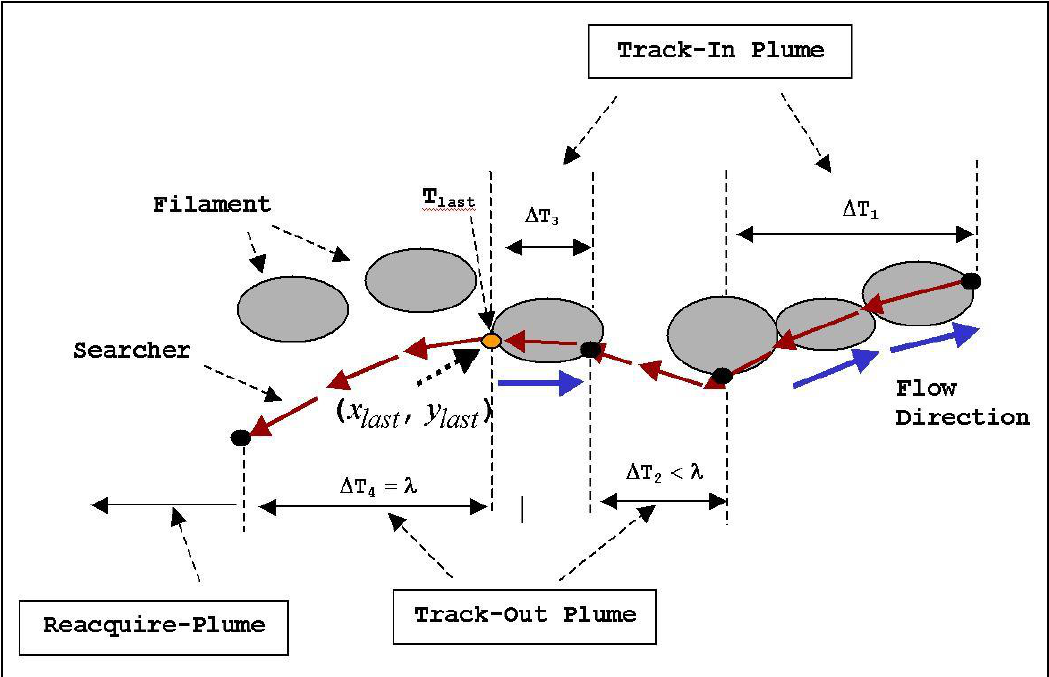
Figure 4. Derive source identification algorithms from moth-inspired plume tracing